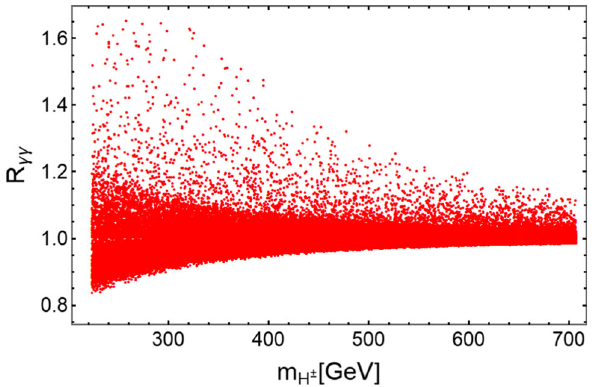
Fig. 5 Higgs diphoton signal strength as a function of the charged scalar mass m H ± , with 600 [ GeV ] < m H ± < 7000 [ GeV